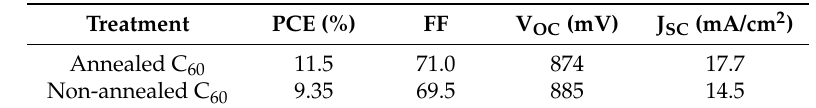
Table 2. Annealing effect of C 60 layer.